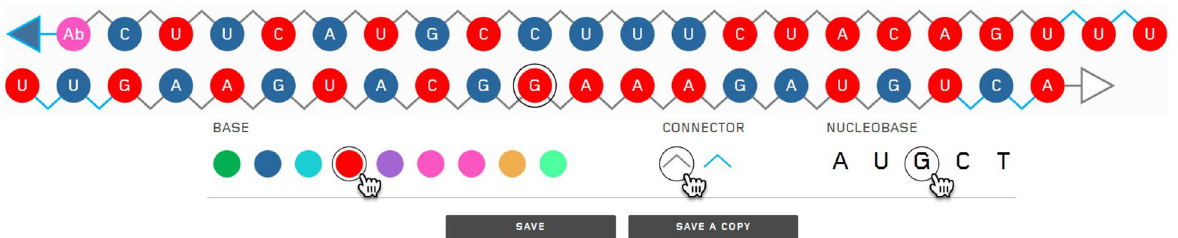
Fig. 8 An example of an siRNA duplex molecule with complete interactivity of each visual